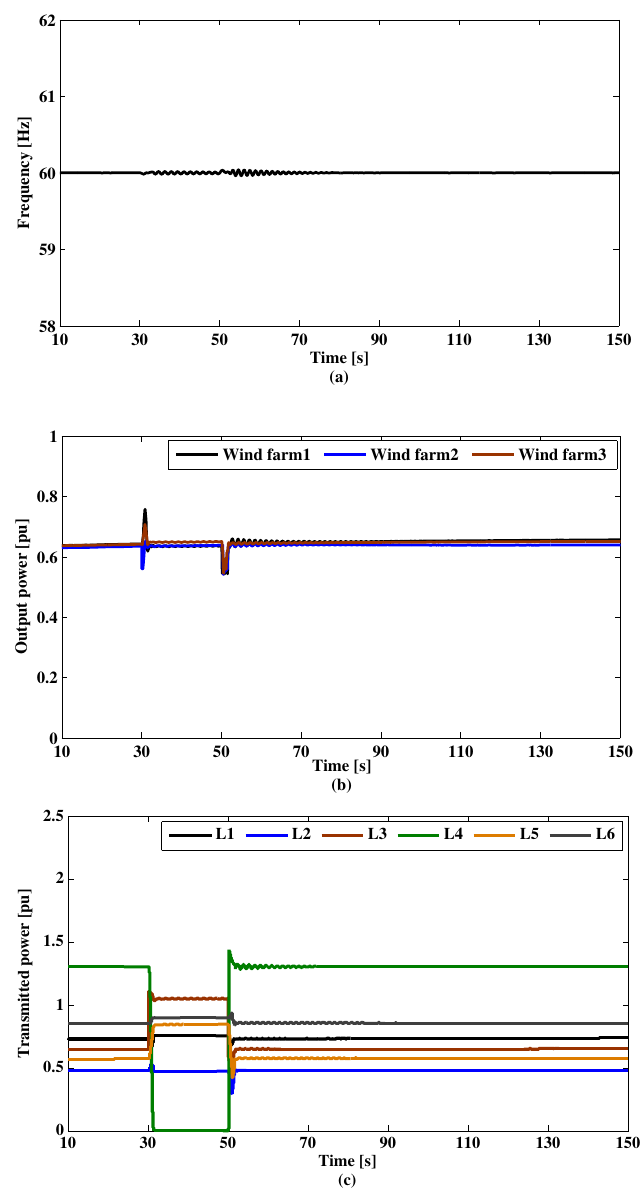
Figure 13. Case 4 result. ( a ) System frequency. ( b ) Generated output power of wind farms. ( c ) Transmitted